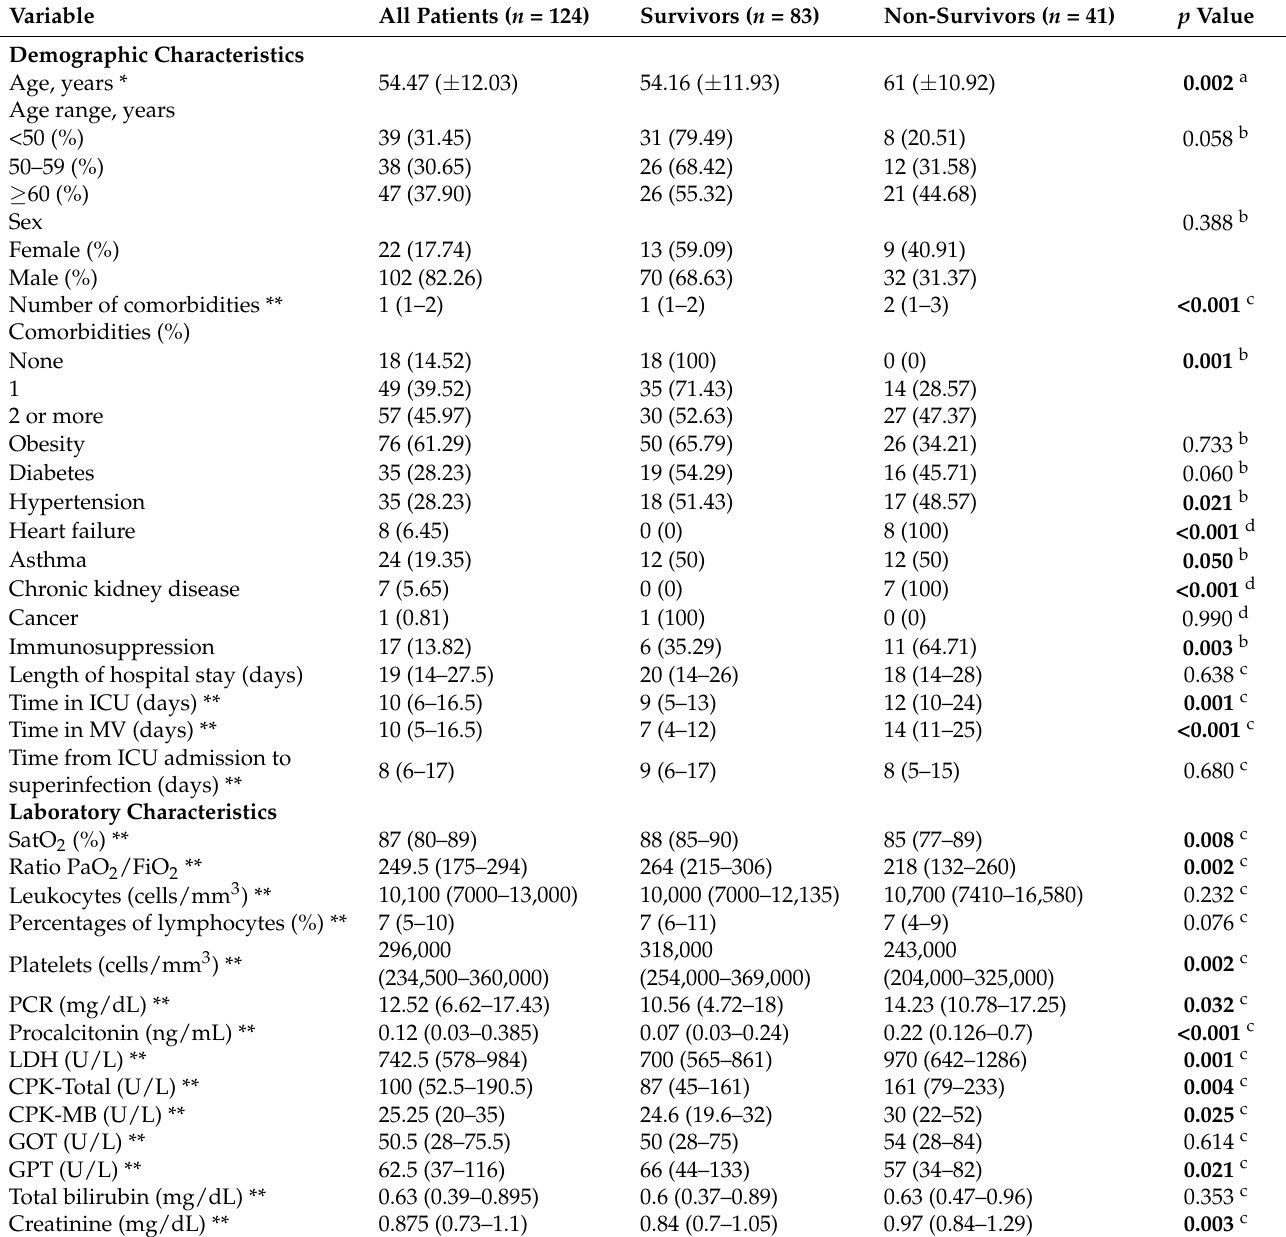
Table 1. Clinical and laboratory characteristics of the study population and comparison between survivors and non-survivors.